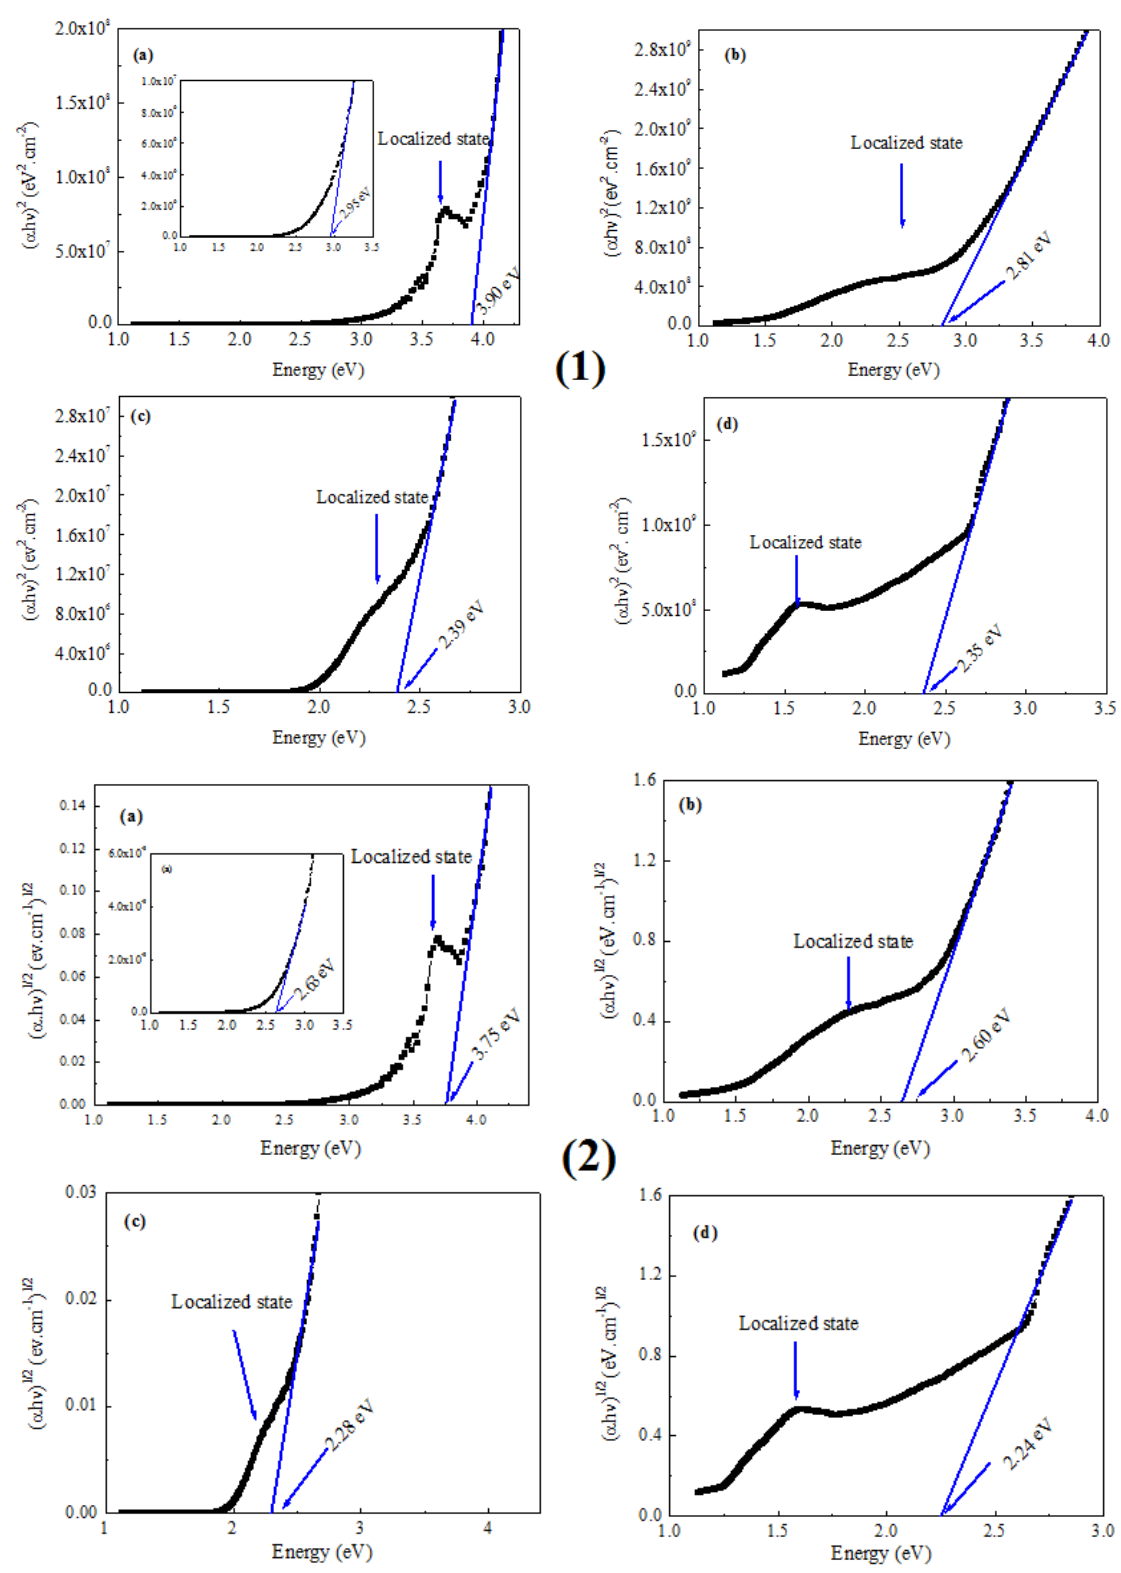
Figure 18. Evaluation of direct ( 1 ) and indirect ( 2 ) band gap for doped PANI in the not-annealed ( a ) and annealed ( b ) states and those of the doped PANI/SWCNT composite in the not-annealed ( c ) and annealed ( d ) states. The inset of ( a ) shows the threshold energy of localized states created by doping.